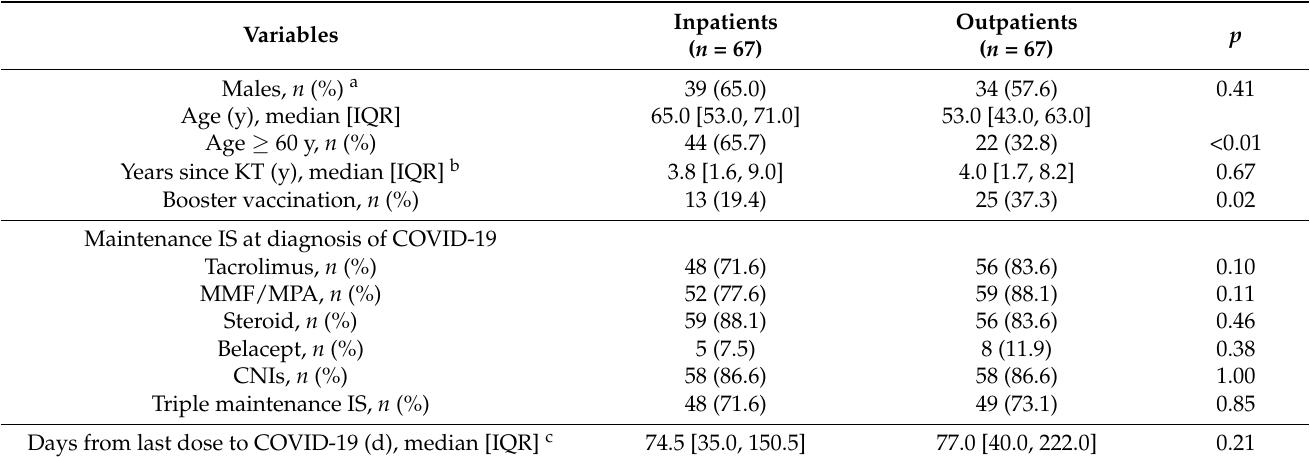
Table 5. Comparison between inpatients and outpatients with COVID-19 breakthrough